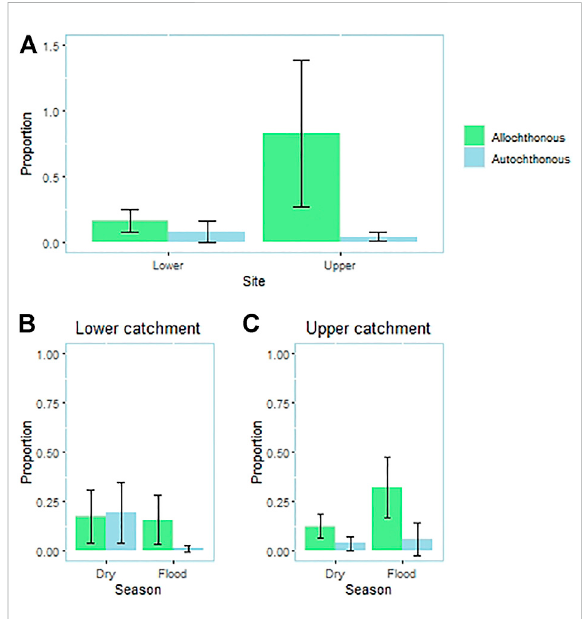
FIGURE 2 Comparisonbetweenthevolumeofresourcesofaquaticand terrestrialorigin(riparianvegetation)between (A) sitesandseasons ( fl ood and dry season) in the (B) lower catchment and (C) upper catchment). Although we used a permutational ANOVA, mean values and error bars are shown for clarity.